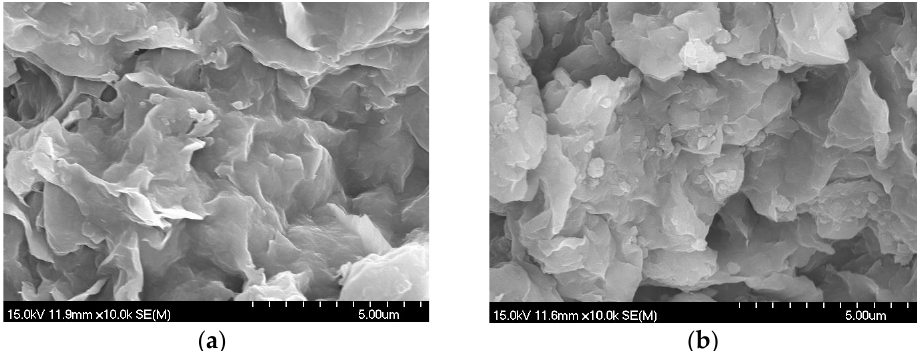
Figure 11. The effect of process treatment on material micromorphology. ( a ) Bentonite SEM image after adding zeolite; ( b ) Bentonite SEM image without zeolite.